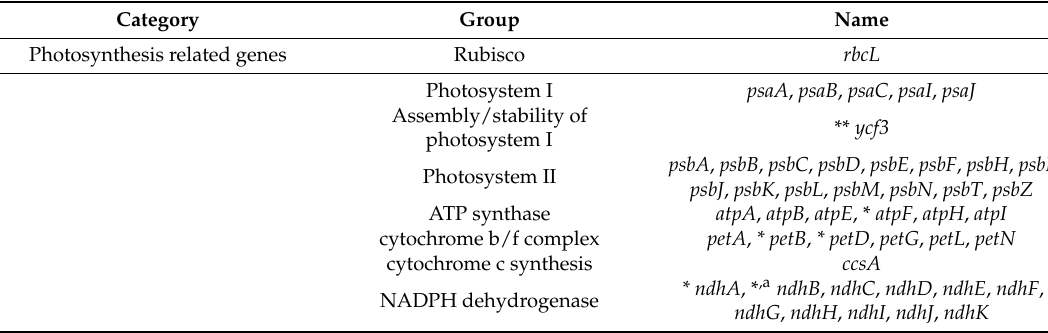
Figure 1. Gene map of Rehmannia chloroplast genomes. Genes shown outside the outer circle are transcribed clockwise and those inside are transcribed counterclockwise. Genes belonging to different functional groups are color coded. Dashed area in the inner circle indicates the GC content of the chloroplast genome. ORF: open reading frame. Table 3. Gene list of plastomes of six Rehmannia species.